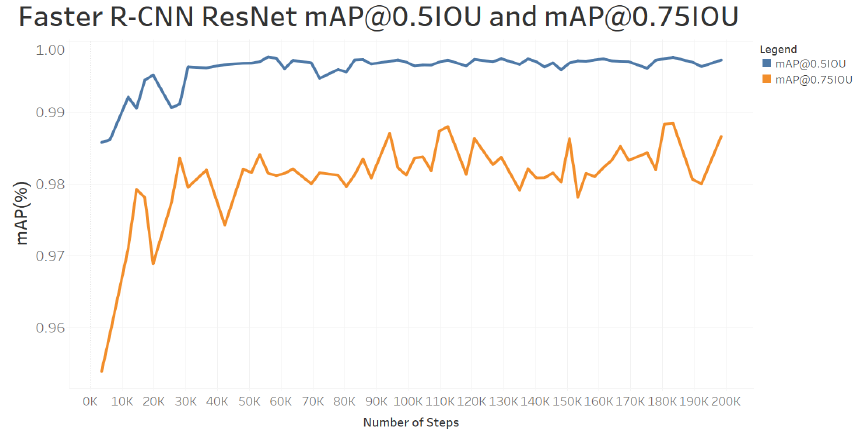
Figure 9. The Faster R-CNN model stabilizes at an mAP above 99.5% at 0.5 IoU and oscillates above 98% at 0.75 IoU by the end of the training period.